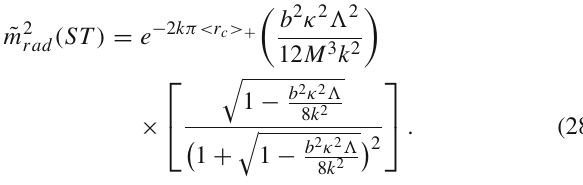
Fig. 1 V ST vs r c ( t ) − 1 ,κv = 0 . 01 h